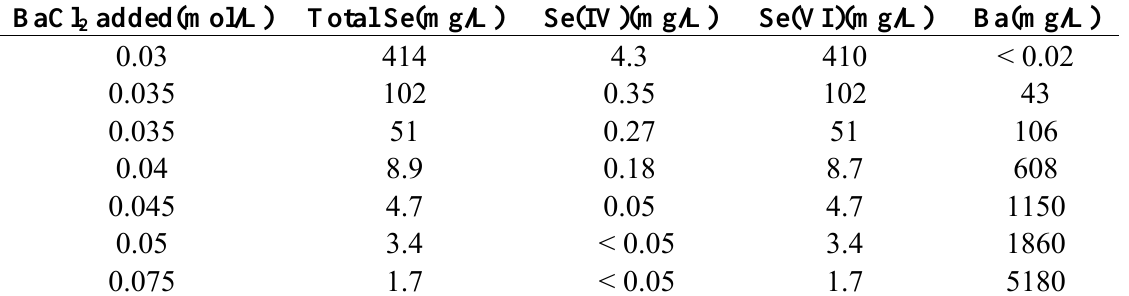
Table 2. Analysis of filtrates from the second